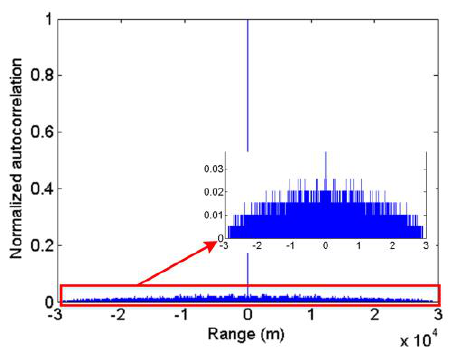
Figure 6. Normalized auto-correlation function of the true random sequence (sequence length 200 μs, mean pulse count density 1 Mcps).